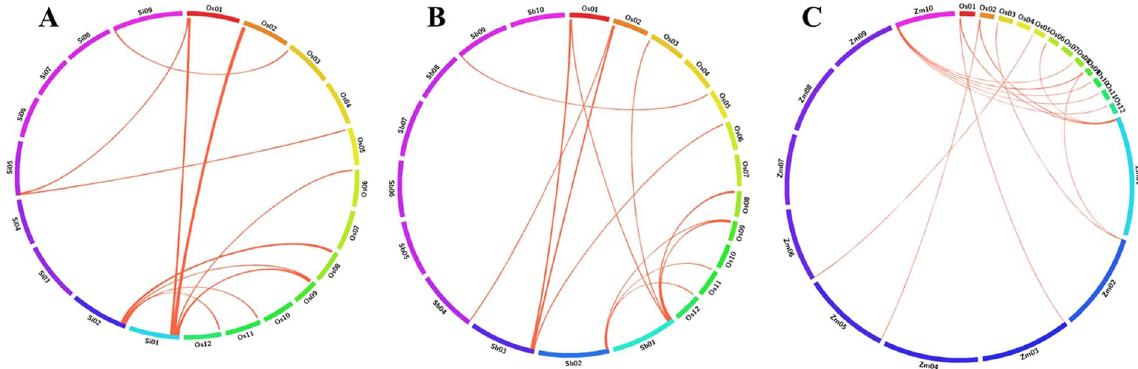
Figure 10. Orthologous relationships between threonine-encoding genes of ( A ) rice and foxtail millet, and ( B ) rice and sorghum, and ( C ) rice and maize. Each segment indicates chromosome and the orthologous genomic regions are marked with